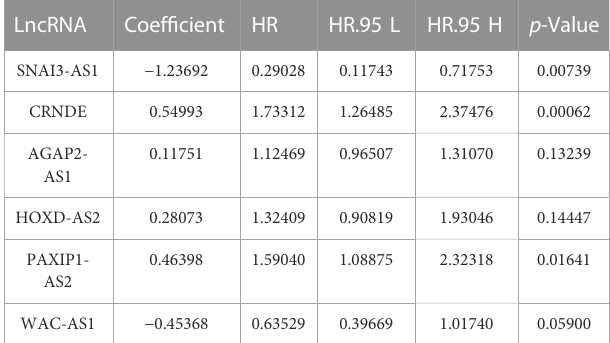
TABLE 2 The 6 senescence-related prognostic lncRNA multivariate Cox regression analyses of OS in glioma patients.